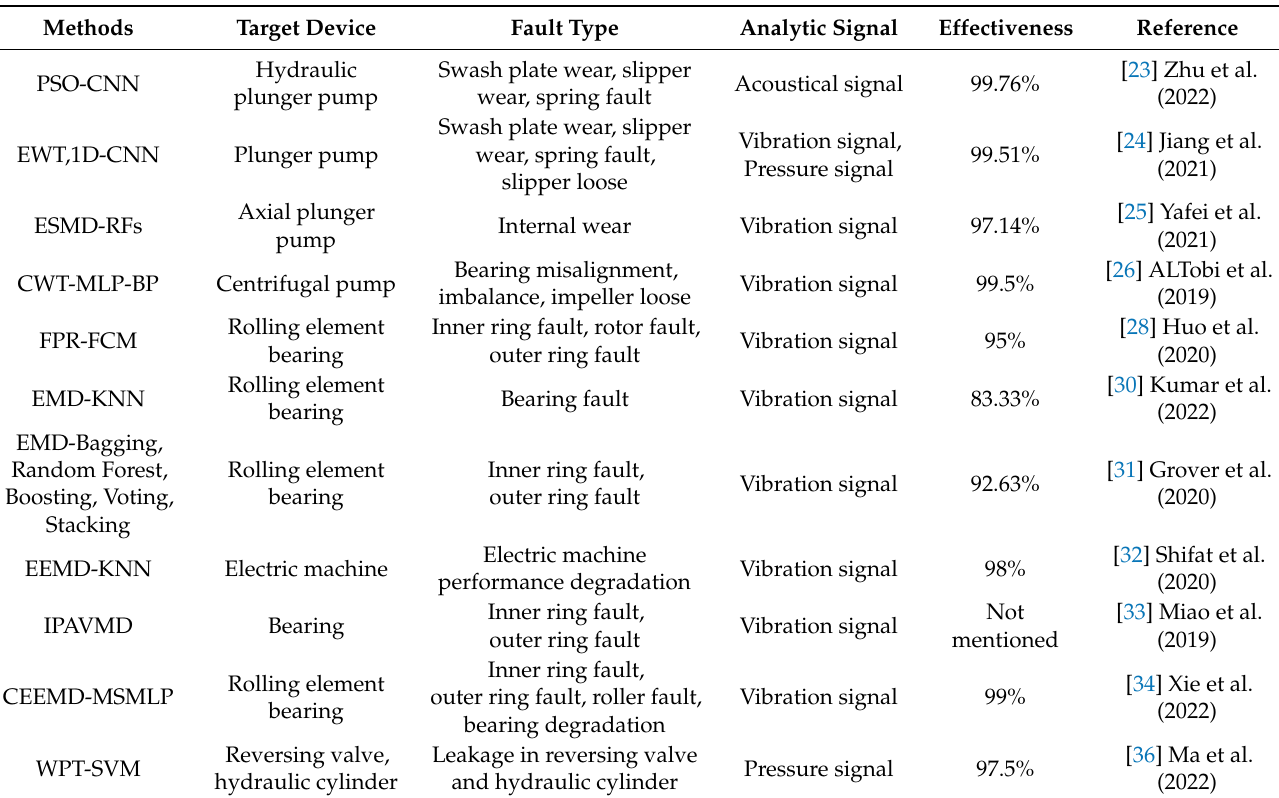
Table 1. Analysis of different methods for fault